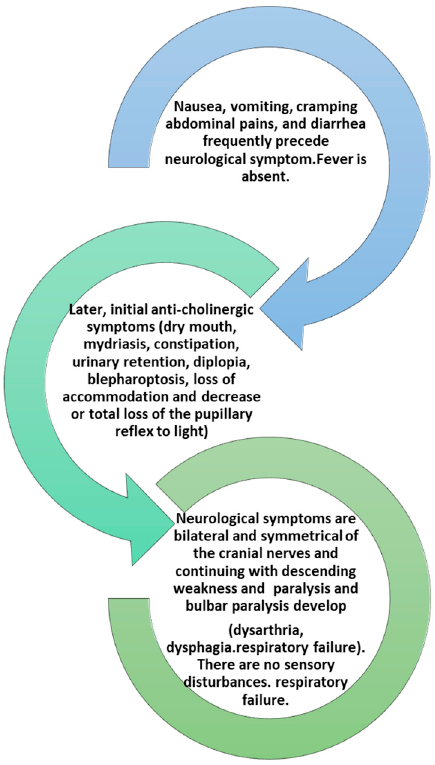
Figure 2. The development of clinical symptoms in an intoxication from BoNTs.